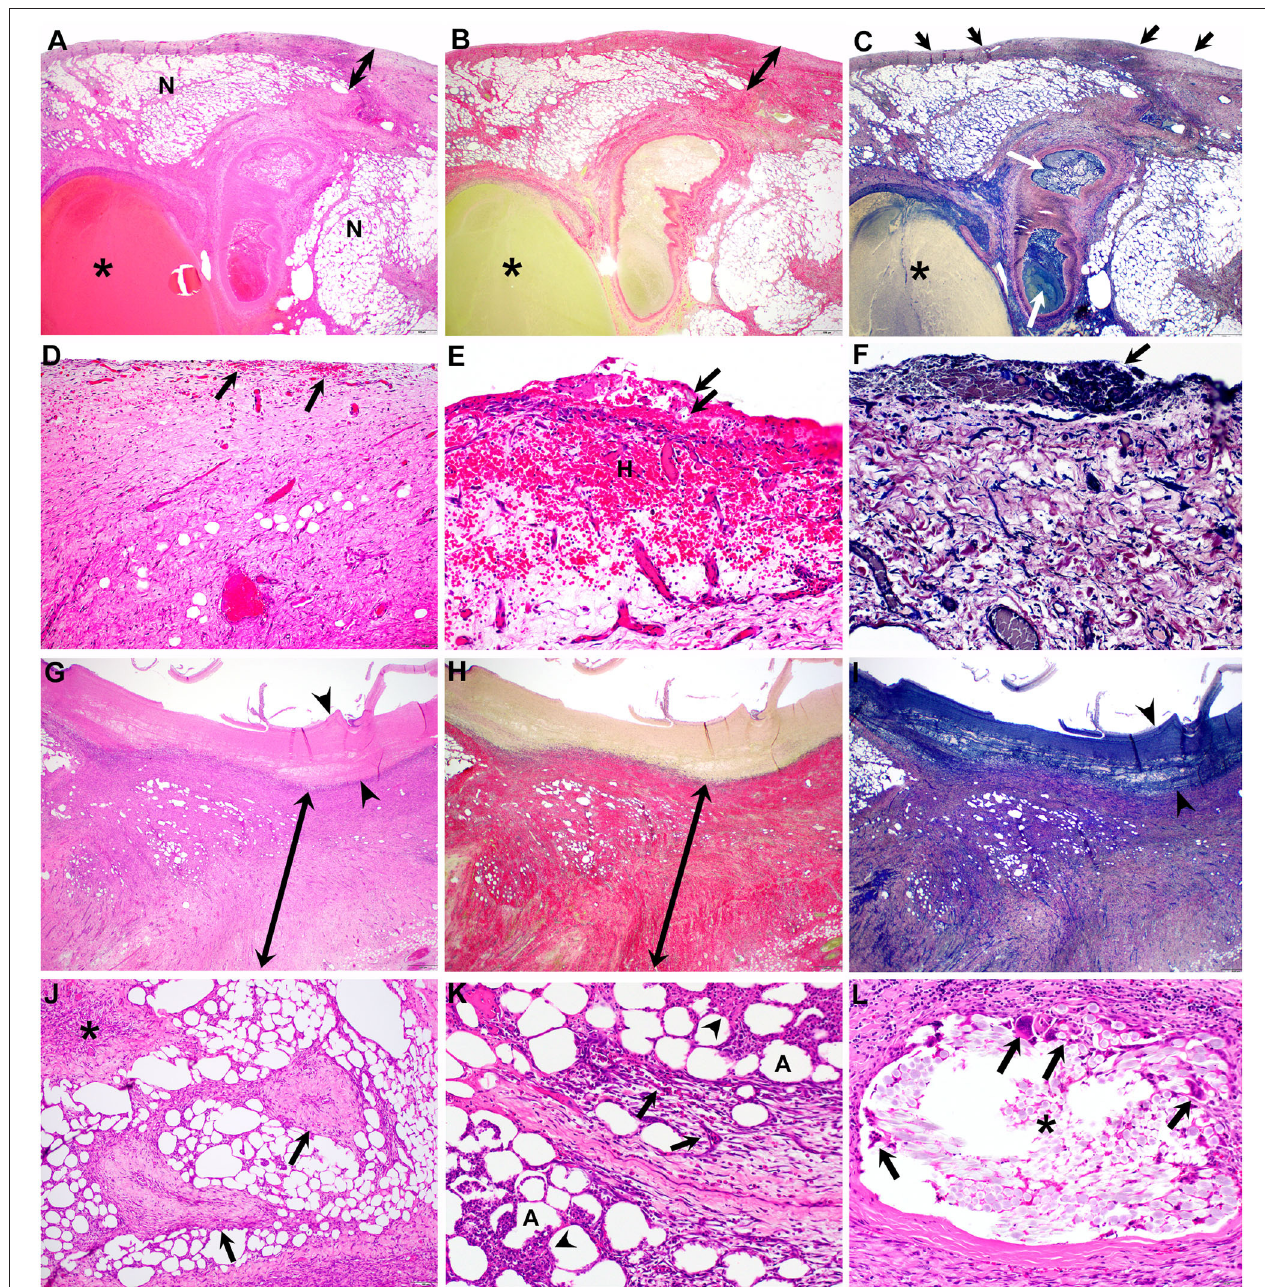
FIGURE 3 | Photomicrographs of H&E ( A,D,E,G, J–L ), PSR ( B,H ) and PTAH ( C,F,I ) stained sections of the jejunal mesenteric remnant at the NCT site. (A–C) On low (2 × ) magnification, the subserosal tissue is expanded by a well-defined rim of collagen-rich granulation tissue (double-headed arrows) that encapsulates islands of necrotic mesenteric adipose (N) with interspersed vasculature including dilated veins (asterisks) and arteries occluded by fibrin aggregates (C, white arrows); tiny accumulations of fibrin are associated with the serosal surface (C-arrows). (D–F) High (20 × ) magnification photomicrographs of the subserosal tissue featured in (A–C) reveals small scattered foci of hemorrhage (D-arrows) that rarely coalesce (E–H) or extend to the serosal surface, which contains small ( ∼ 200 µ m) aggregates of fibrin (E,F-arrows). (G–I) Low (2 × ) magnification photomicrographs of the NCT-tissue interface shows a thin ( < 1mm) rim of fibrin (arrowheads) containing scant to no inflammation surrounded by a thick ( > 3mm) rim of organized, collagen-rich granulation tissue (double-headed arrows). (J–L) High (10 × ) magnification photomicrographs of adjacent mesenteric adipose reveal islands of coalescing foci of granulation tissue (J-asterisk) interspersed with sclerotic and stenotic arterioles (J-arrows). Areas of inflammation include small foci of fibrin and necrosis (K-arrowheads) and eosinophilic granulomatous infiltrates with multinucleate giant cells (K-arrows) centered on necrotic adipocytes (K–A) . Circumscribing suture material (L-asterisk) used to close the mesenteric rent are eosinophilic and granulomatous infiltrates including numerous and large multinucleate giant cells